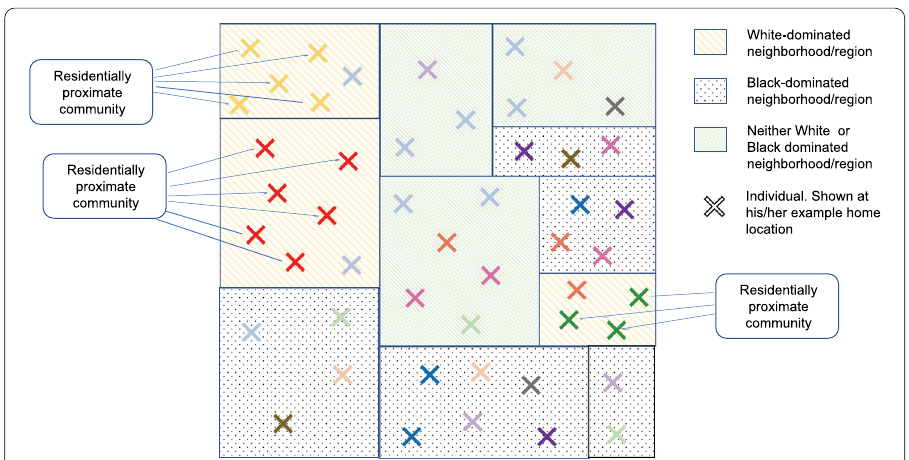
Fig. 1 Toy example showing an example city (outlined by a box) and its neighborhoods (outlined by sub-boxes). Individuals are shown by cross marks. Individuals are placed at their illustrative home locations in an neighborhood. Individuals shown in same color belong to same community. Residentially proximate community refers to group of individuals who reside in the same neighborhood and share same